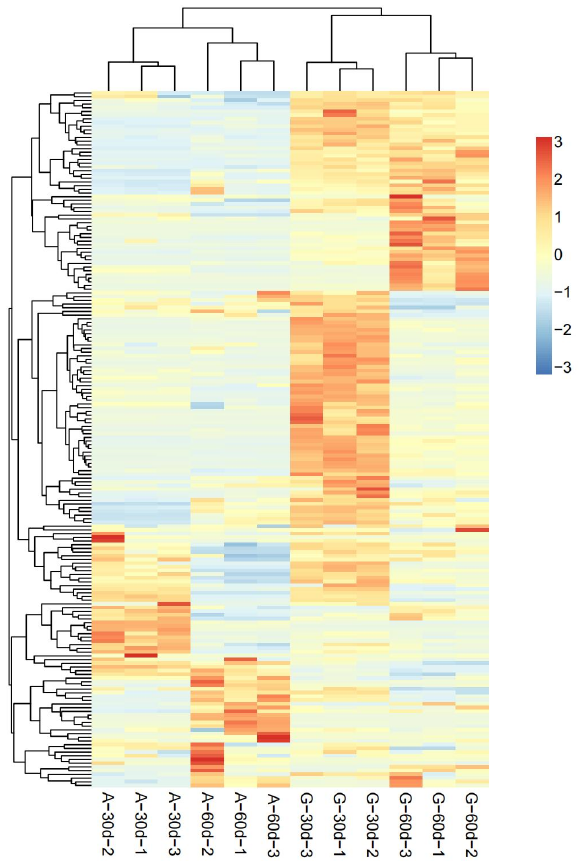
Figure 3. Clustering analysis diagram of DEMs between A. correntina and GH85. A − 30d: A. correntina − 30d; A − 60d: A. correntina − 60d; G − 30d: GH85 − 30d; G − 60d: GH85 − 60d (the same below).